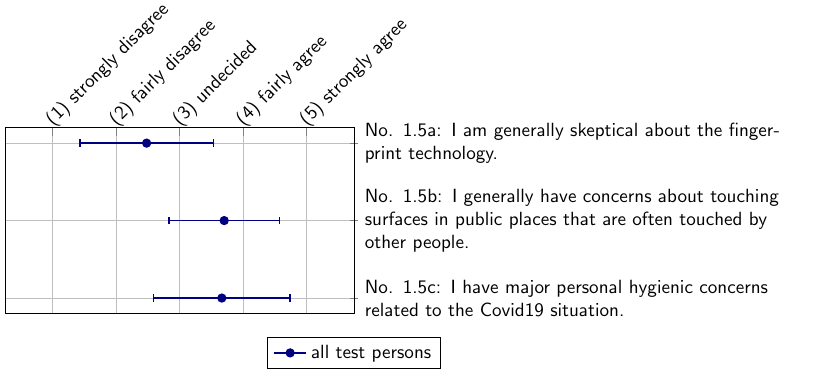
Figure 13. General assessment of fingerprint technology and hygienic concerns.